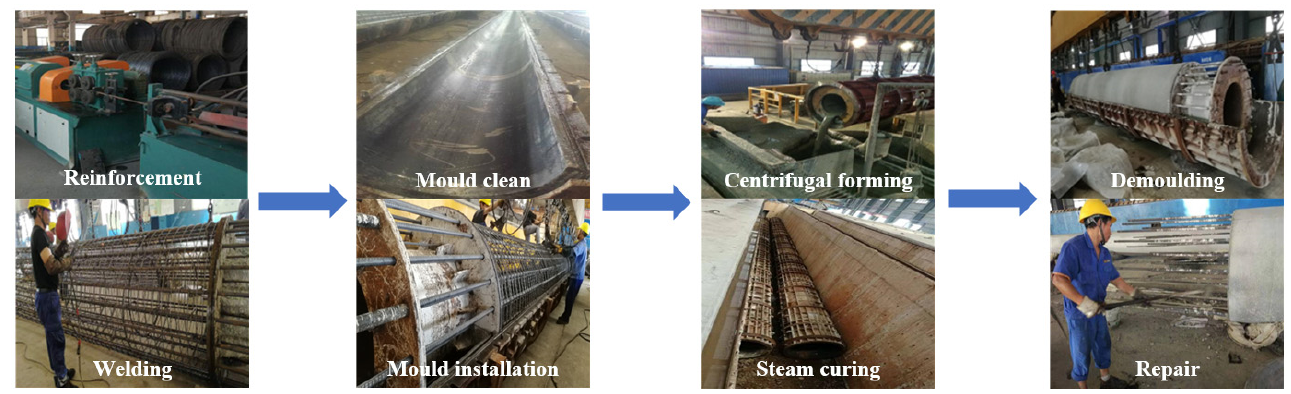
Figure 2. The prefabrication process of pile ‐ column.